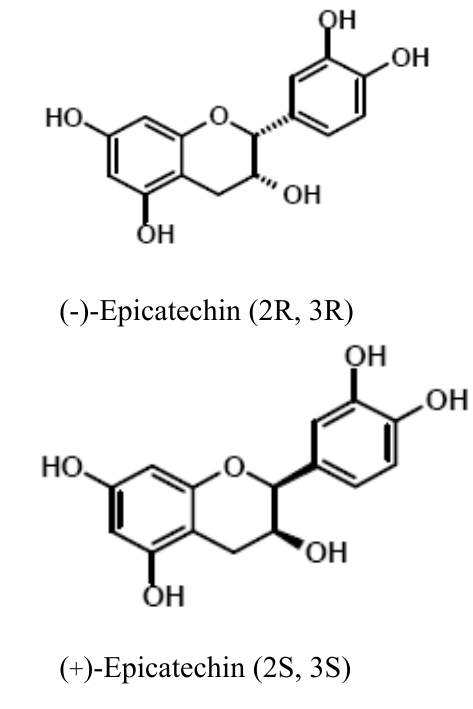
Figure 2. Structures the catechin and epicatechin enantiomers [34,